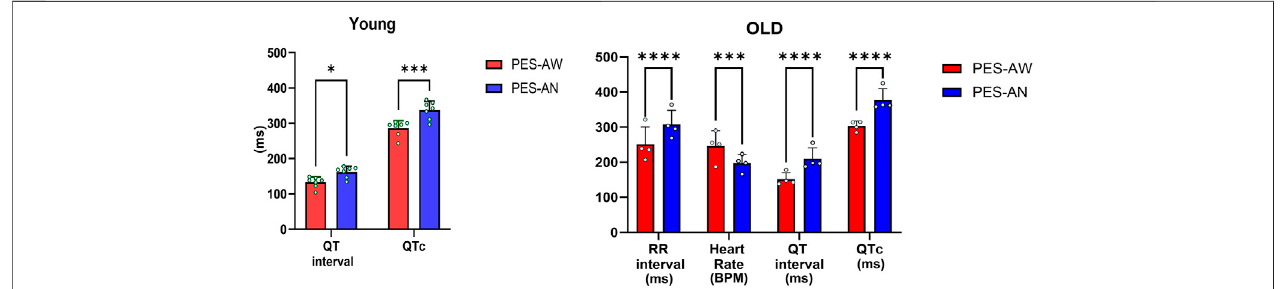
FIGURE 3 | Effect of anesthesia on ECG parameters. Comparisons were made both in younger (n = 7) and older (n = 4) adult animals in awake (PES-AW) and anesthetized condition (PES-AN). 2-way ANOVA with 0.05 FDR cutoff was used to calculate the p values. p p < 0.05, ppp p < 0.001, pppp p < 0.0001.